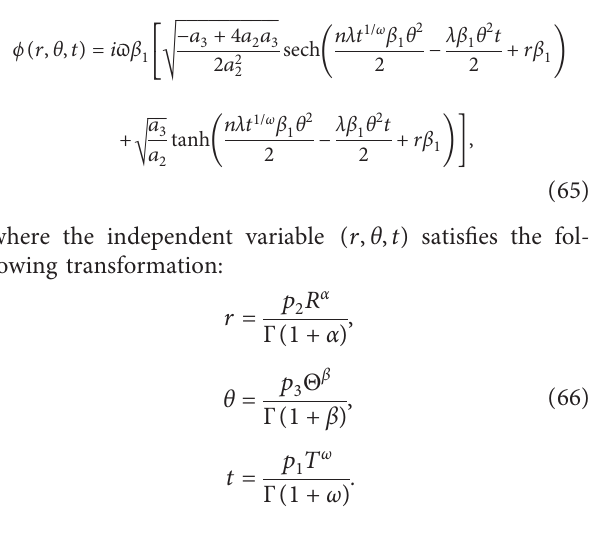
Figure 1: The values of the parameters are as follows. (a) β � 1 . 2, β � 1 . 8, ω � 1, and ϖ � 1. (d) β β 1 3